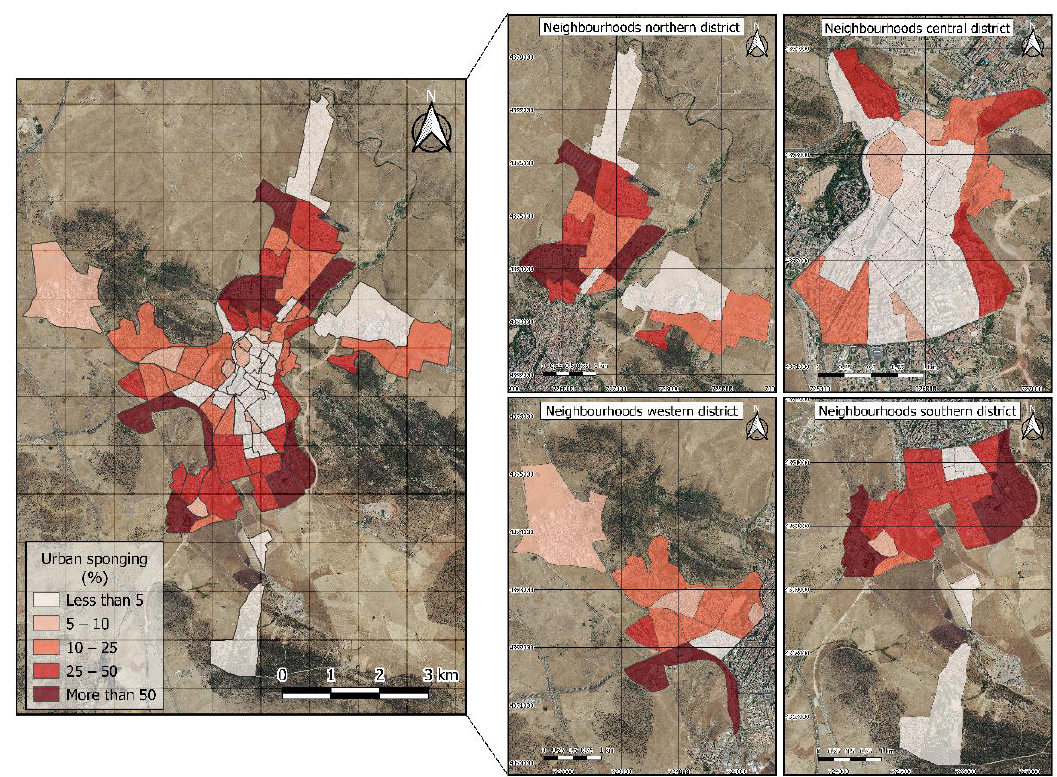
Figure 10. Urban Sponge